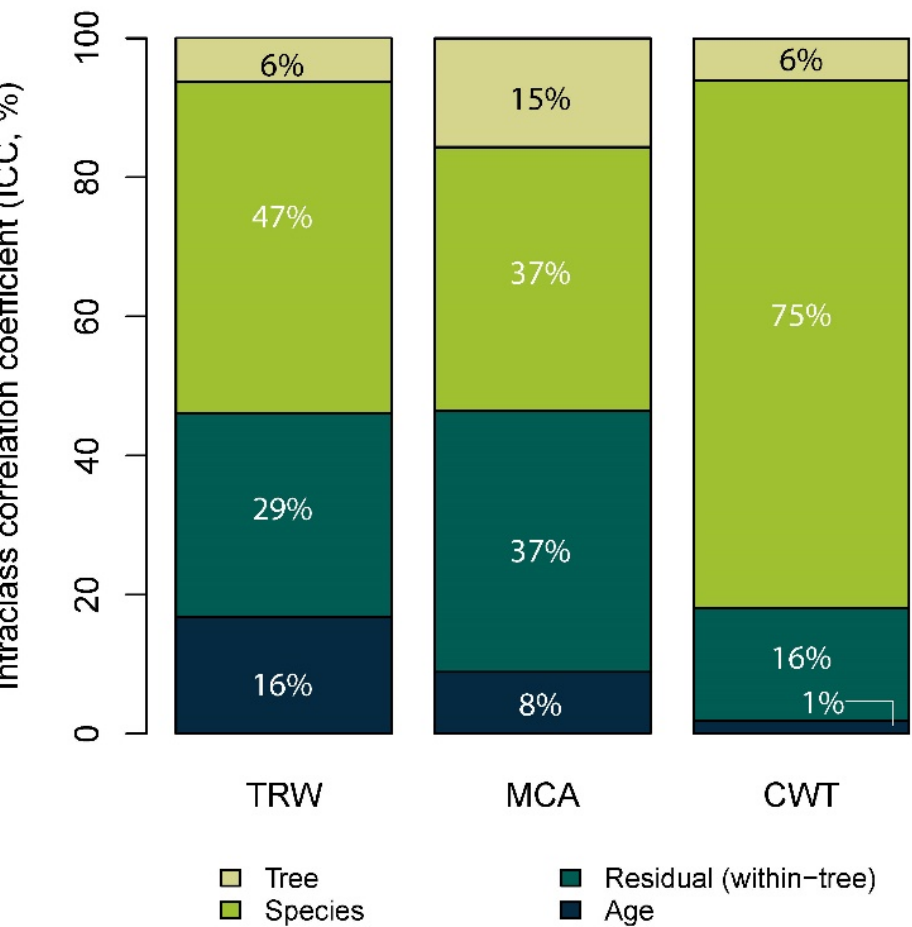
Figure 4. Partitioned intraclass correlation coefficient (ICC, %) for fitted intercept-only linear mixed model for tree-ring width (TRW) and wood anatomical variables (MCA, mean conduit area; CWT, cell-wall thickness). Species , the clustering variable including P. halepensis , P. sylvestris , and P. lumholtzii ; Tree , individual trees; Age , cambial age. ICC was defined as σ 2 i /( σ 2 i + σ 2 ε ), using mixed model random variance terms, and represents the consistency of behavior across multiple measurements, where σ 2 i is the random effect variance term and σ 2 ε is the error variance term from the LMMs. Unexplained variance attributable to residuals is also reported.